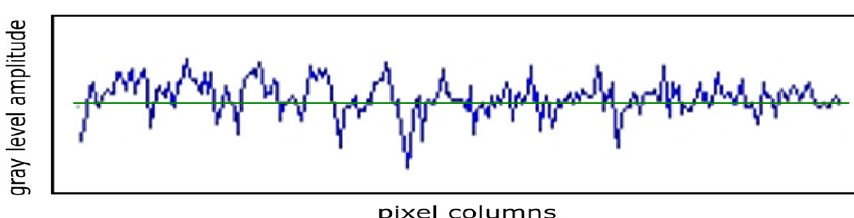
Figure 15. Time series associated with a normal area.